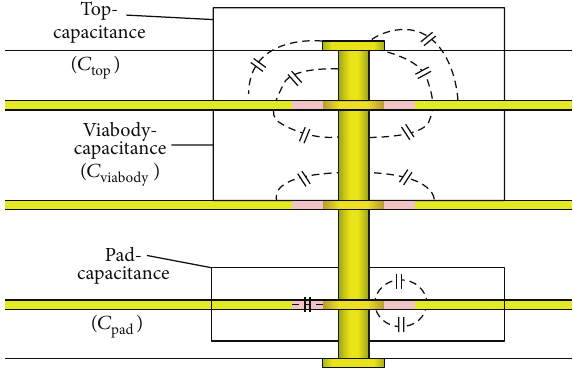
Figure 8: Capacitance of via for each part.